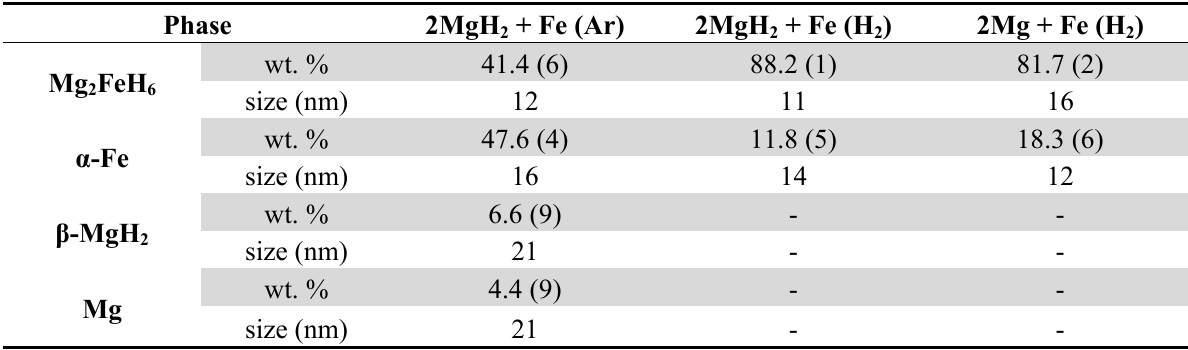
Table 2. Relative quantities and crystallite size of phases identified in the ball milled samples as calculated by Rietveld refinement. In parenthesis are uncertainties on the last significant